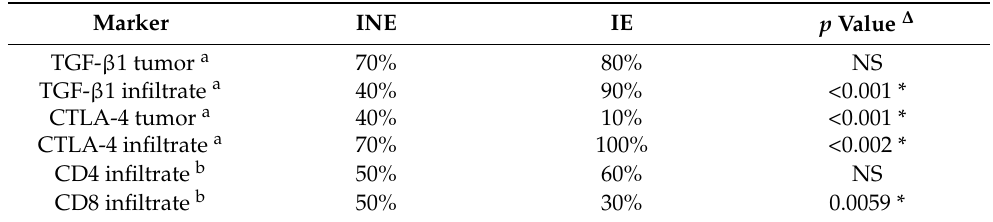
Table 4. TGF- β 1 and CTLA-4 expression profile in tumor tissue and immunological infiltrate from tumor